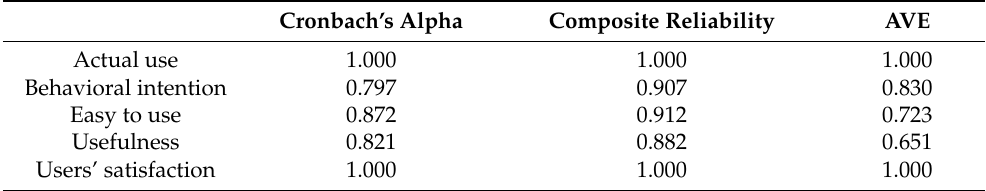
Table 3. Validity and reliability.